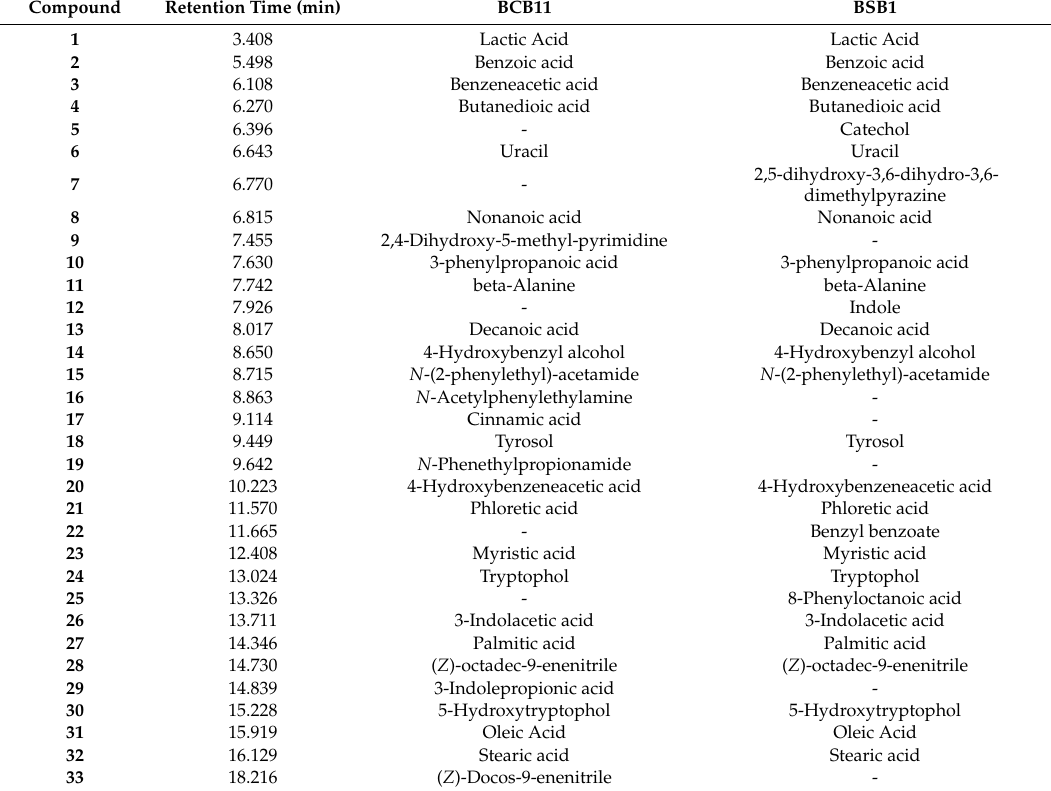
Figure 2. Phylogenetic tree of BSB1 ( MK715467 ) and BCB11 ( MK715464 ) strains, based on 16S rDNA sequence analysis, and constructed using the neighbor-joining method. The level of bootstrap values (expressed as a percentage of 1000 repetitions) is indicated at all nodes to be greater than 50%. Table 3. Identification of metabolites by GC–MS 1 in the ethyl acetate extracts of the fermentation medium of Enterobacter